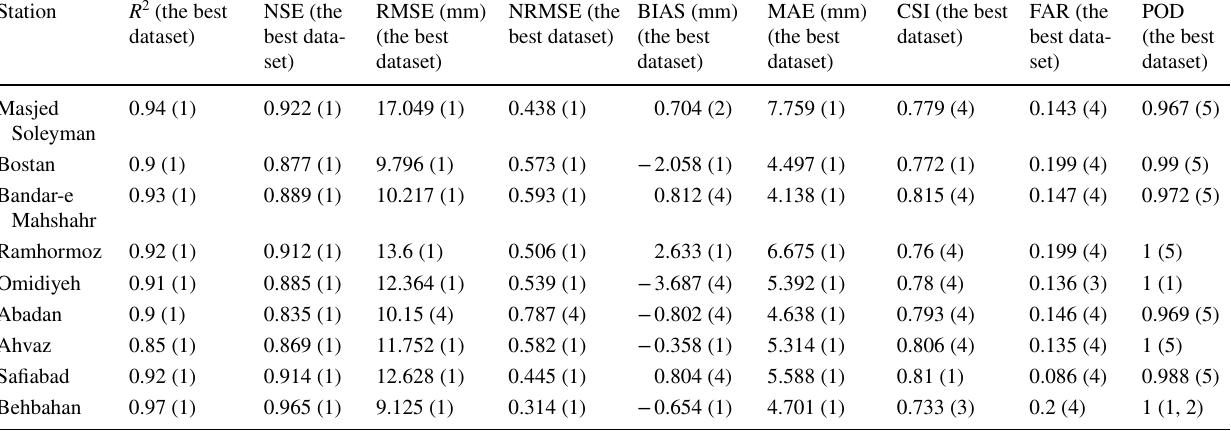
Table 4 The values of performance criteria for the best-selected PCP dataset based on fitness with observed PCP (APHRODITE = 1,